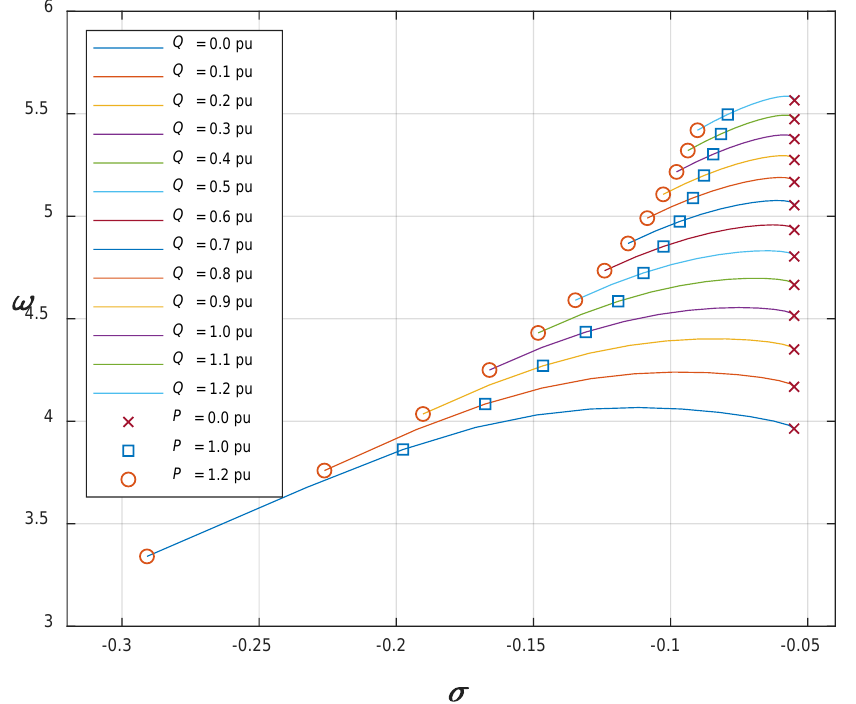
Figure 1. Eigenvalue loci of local mode of 9-MVA hydro-type synchronous generator without AVR.